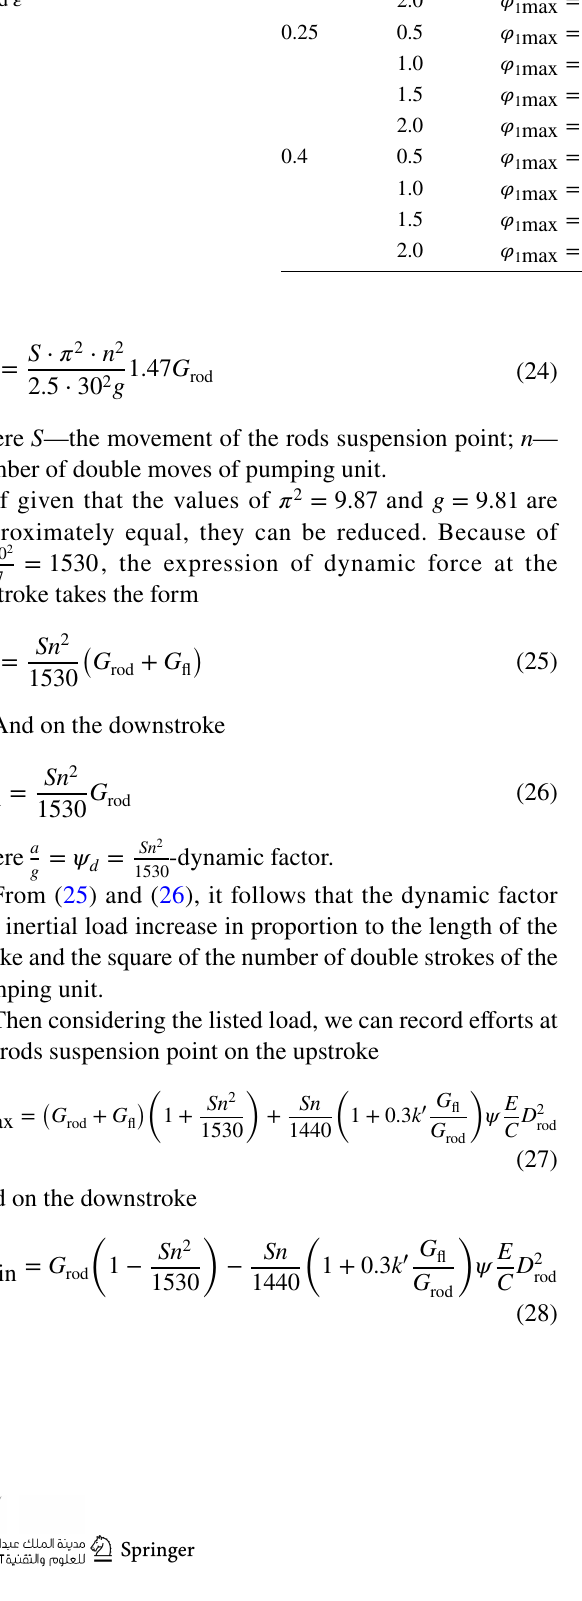
Table 2 The value of the maximum acceleration of the rods suspension point at the corresponding angles of rotation of the crank, depending on the dimensionless parameters 𝜆 and 𝜀